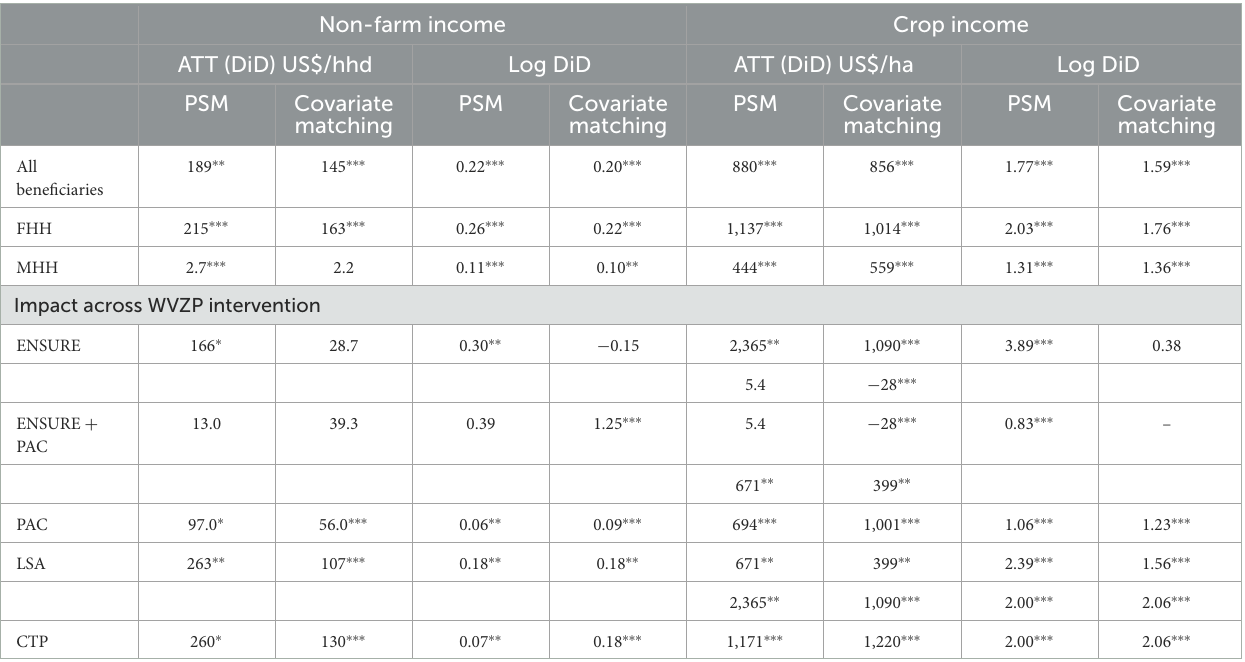
TABLE 10 Impact of WVZP on non-farm and crop